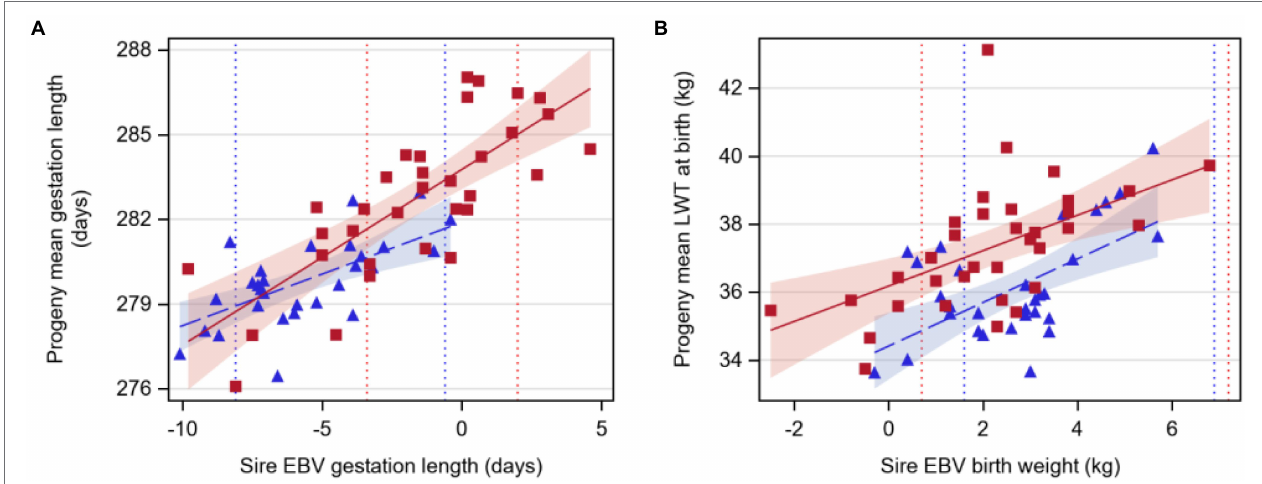
FIGURE 1 | Regression of least-squares means of beef-cross-dairy progeny groups on sire EBV for: (A) gestation length (days) and (B) liveweight at birth (LWT, kilograms). Individual sires are represented by one data point (Angus, triangles, n = 30; Hereford, red squares, n = 34), and the regression lines by breed are indicated by lines (Angus, dashed line; Hereford, solid line). Shaded areas indicate 95% confidence intervals for the expected regression line for each breed (Angus, blue; Hereford, red). Colored dotted lines indicate 5 and 95th EBV percentiles for 2018 born calves within the BREEDPLAN population for each breed (Angus, blue; Hereford, red). Details of regression coefficients are presented in Table 3 .